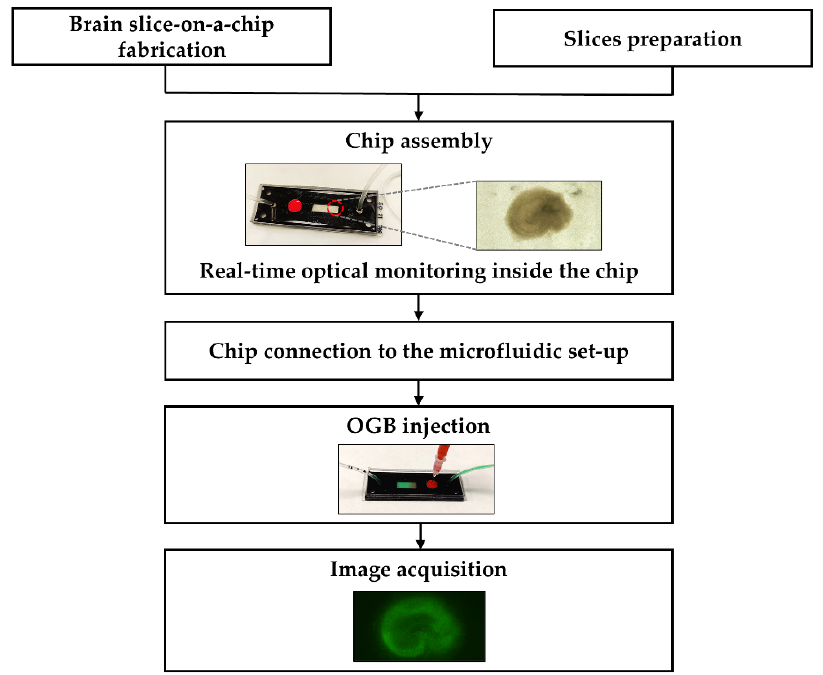
Figure 6. Flowchart showing the main procedures conducted for the brain slice culture and micro- scope scope monitoring.